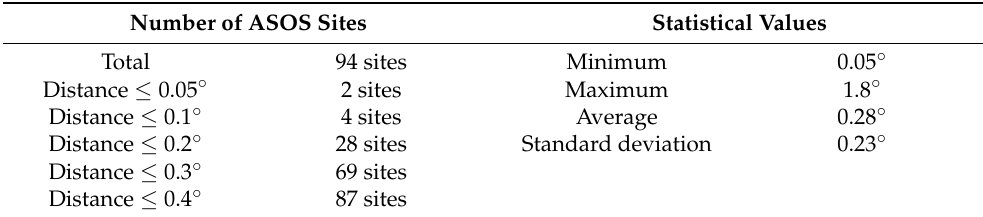
Table 2. Number of ASOS sites and statistical values of distance between specific ASOS site and nearest site. Number of ASOS Sites Statistical Values Total 94 sites Minimum 0.05 ◦ Distance ≤ 0.05 ◦ 2 sites Maximum 1.8 ◦ Distance ≤ 0.1 ◦ 4 sites Average 0.28 ◦ Distance ≤ 0.2 ◦ 28 sites Standard deviation 0.23 ◦ Distance ≤ 0.3 ◦ 69 sites Distance ≤ 0.4 ◦ 87